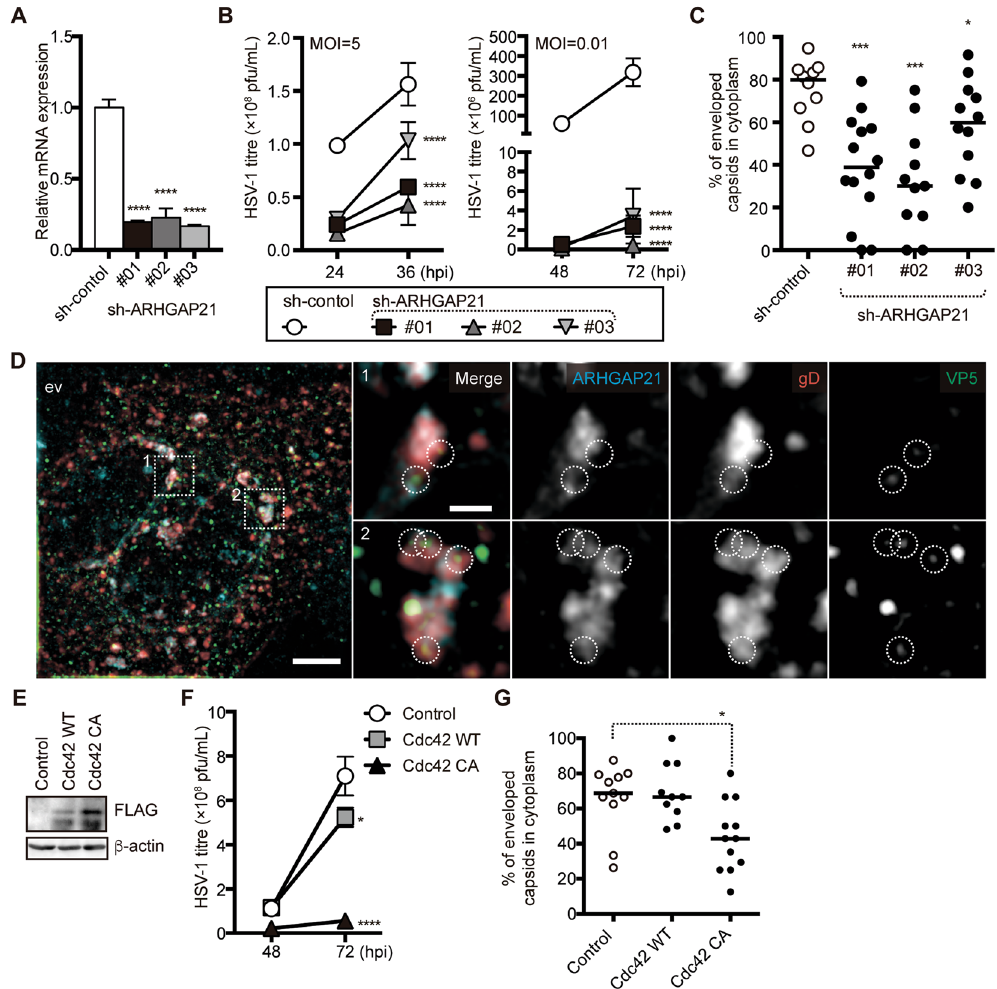
Figure 4. The ARF1-ARHGAP21-Cdc42 pathway is a crucial regulator of HSV-1 replication. ( A ) qRT-PCR analysis of ARHGAP21 mRNA in A549 cells transduced with sh-control- or sh-ARHGAP21-expressing lentivirus vector. GAPDH was used as an internal control. ( B and F ) A549 cells transfected with sh-control and sh-ARHGAP21-expressing lentivirus vector ( B ) or GFP- (control), Cdc42 WT-, and Cdc42 CA-expressing retrovirus vector ( F ) were infected with HSV-1 (moi of 5). Titres in the cell supernatant of HSV-1-infected cells were determined by plaque assay at the times indicated. ( C and G ) Percentages of enveloped capsids versus total capsids in the cytoplasm, calculated by counting capsids in TEM images of HSV-1-infected A549 cells transfected with control and sh-ARHGAP21-expressing lentivirus vector ( C ) or with GFP- (control) and Cdc42 CA-expressing retrovirus vector ( G ). ( D ) Representative super-resolution images of HSV-1-infected A549 cells (moi of 5/12 hpi) transfected with control (ev) lentivirus vector. Cells were simultaneously stained with anti-gD antibody (red), anti-VP5 antibody (green), and anti-ARHGAP21 antibody (cyan). The furthest left panel shows z-stack images reconstructed by maximum intensity projection (bars, 5 µ m) and the other panels show magnifications of the two areas boxed with dashed lines in the left panel (bars, 1 µ m). The circles indicate capsids associated with or included in gD-positive membrane compartments. ( E ) Western blot analysis of FLAG-fusion proteins and β -actin in A549 cells transduced with GFP- (control), Cdc42 WT-, and Cdc42 CA- expressing retrovirus vectors. In ( A,B , and F ), the data represent the means ± s.d. ( n = 3). In ( C and G) , the bars represent the medians. In ( A–C , F , and G ), the asterisks indicate the p value ( t -test in ( A , C , and G) and two-way ANOVA in B and F ) compared with sh-control ( A – C ) or GFP (control) ( F and G ). * p < 0.05, *** p < 0.005, **** p < 0.001.